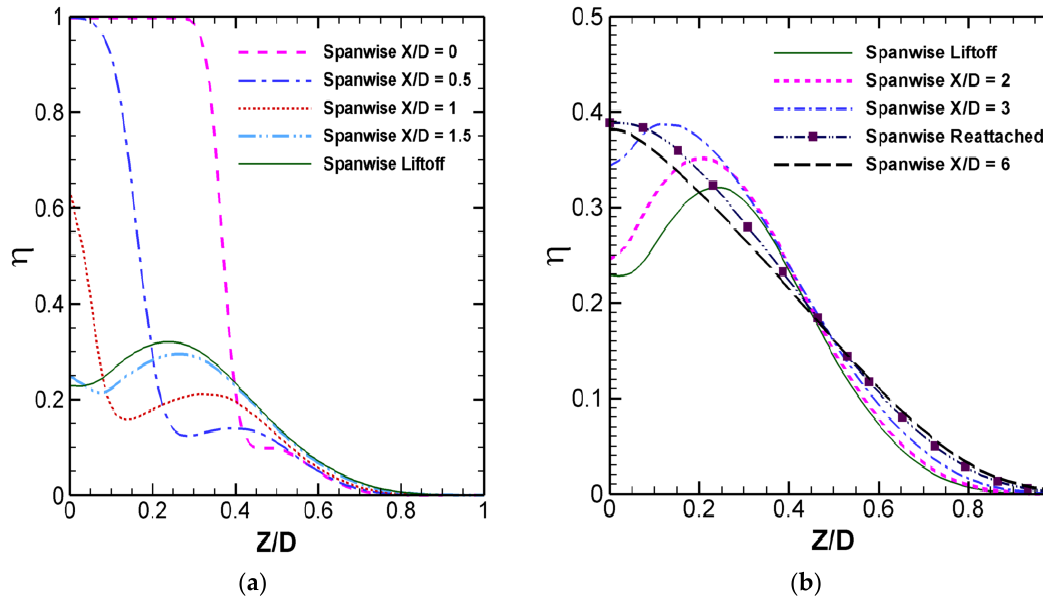
Figure 13. Span-wise film-cooling effectiveness. ( a ) η sp before liftoff; ( b ) η sp after